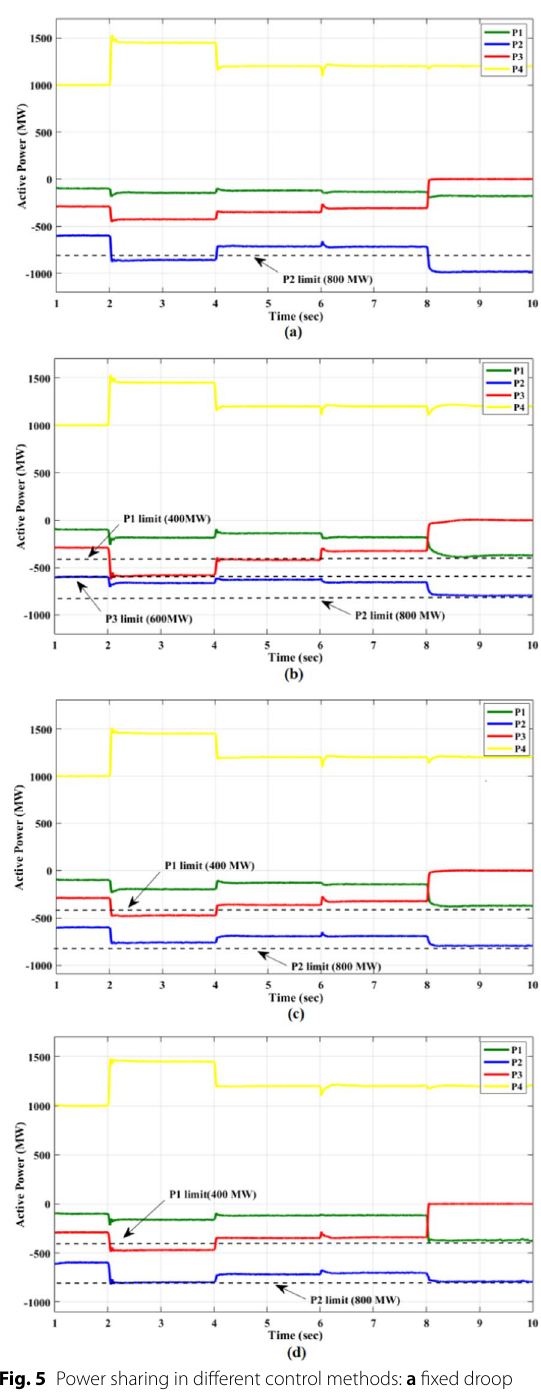
Fig. 5 Power sharing in different control methods: a fixed droop control. b P-based adaptive droop control. c P–V-based adaptive droop control. d proposed adaptive droop